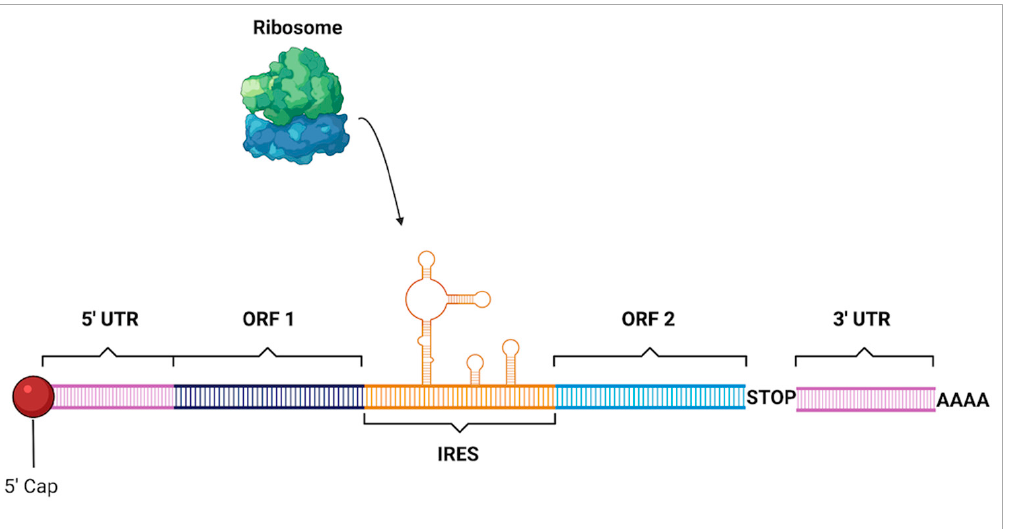
Figure 9. Internal ribosomal entry site. Internal ribosomal entry sites (IRES) are complex secondary structures that form within mRNA that allow mammalian ribosomes to bind and begin translation of open reading frames (ORF) in a cap-independent manner which bypasses traditional initiation at the 5’ cap near the 5’ untranslated region (UTR).